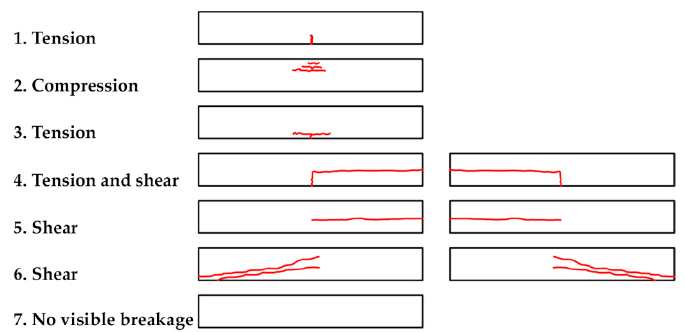
Figure 4. Classification of types of failure.